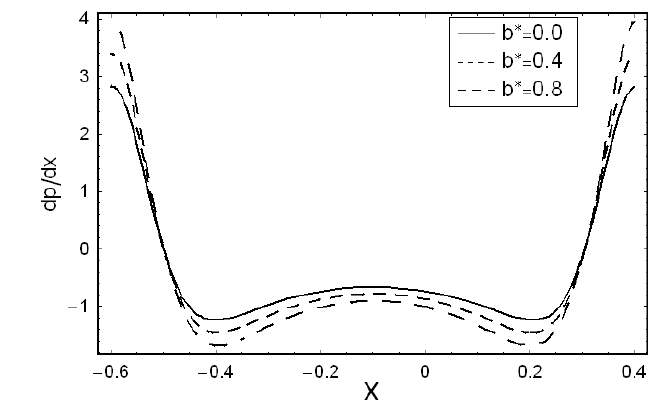
Figure 2. Variation in dp / dx for b ∗ with a = 1.0, b = 0.7, d = 1.2, n = 1.5, φ = π /2 and Θ = 1.